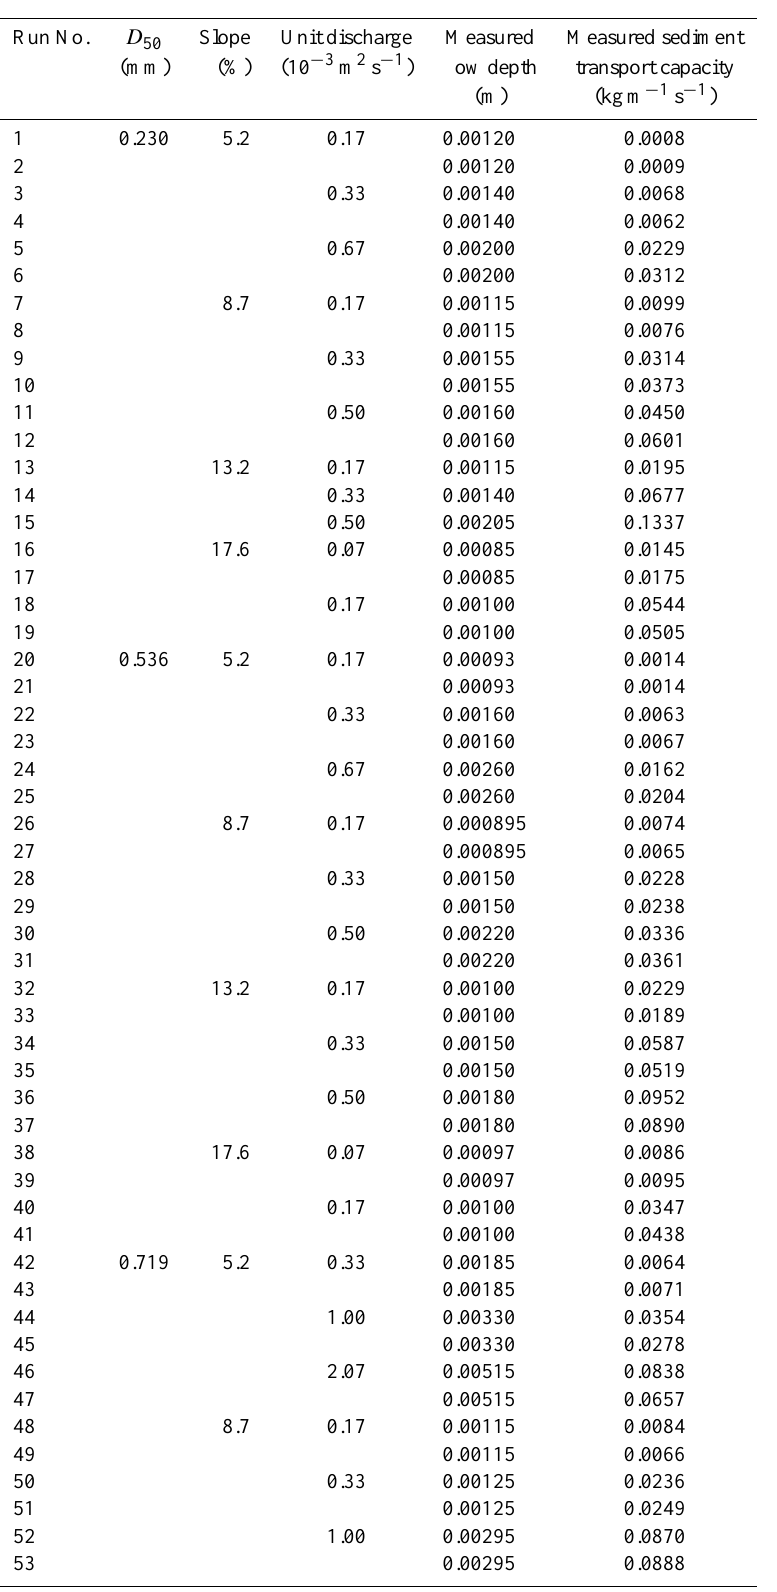
Table 1. Experimental